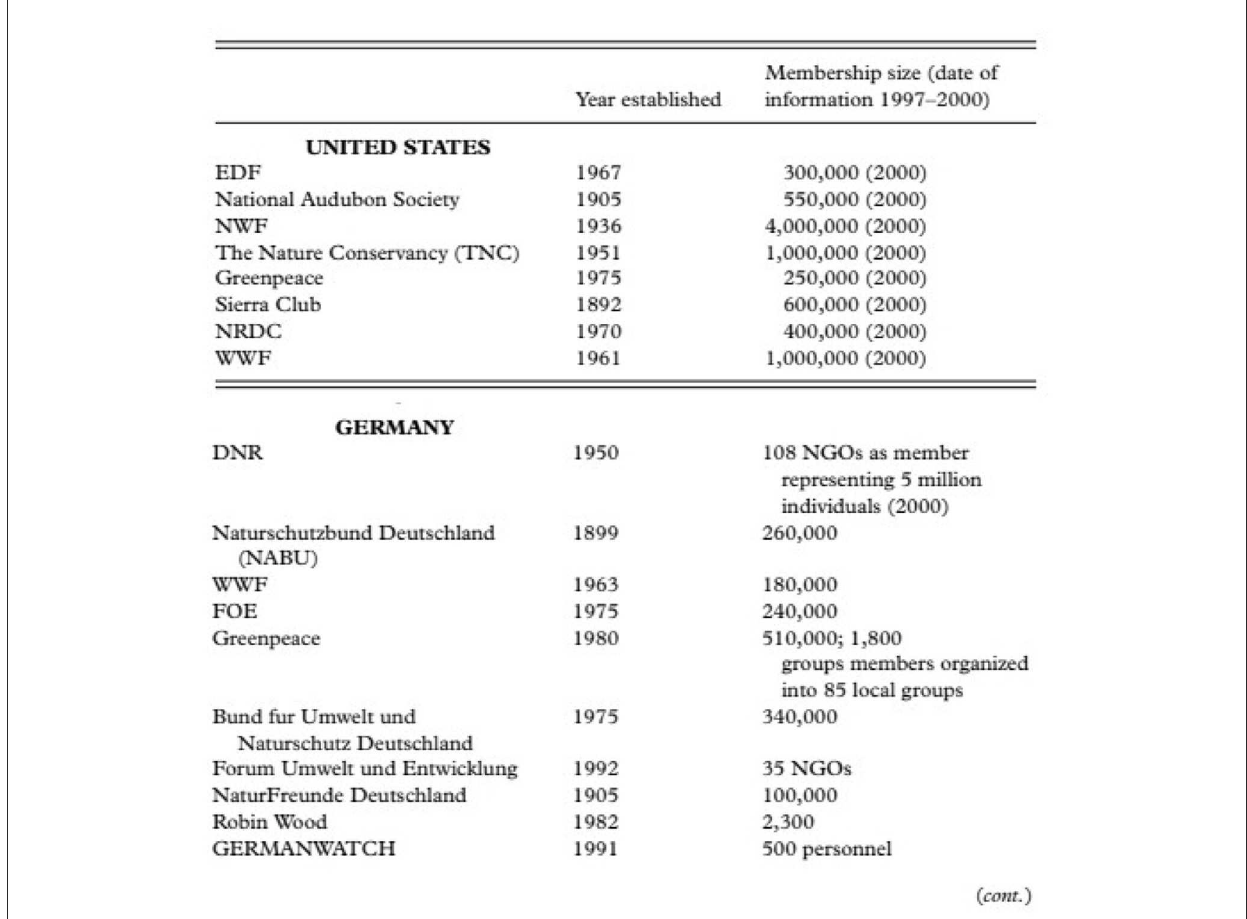
FIGURE7 Comparison between US and German environmental NGOs. US environmental NGOs are much bigger than Germany’s. The study from which this figure derives (Schreuer’s “Environmental Politics in Japan, Germany and the United States,” in bibliography) emphasizes that there are many environmental groups in the US with budgets in the millions, while similar groups in Germany are much poorer. Although it is important to highlight that at the beginning of the new millennium, the population of the US was 3.5 times bigger than